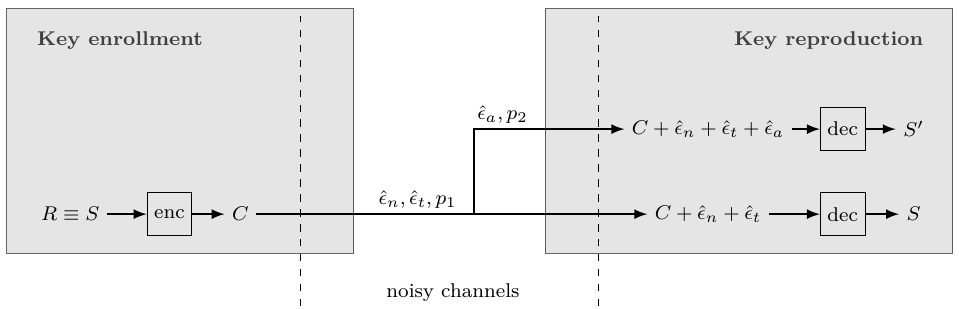
Figure 11: A wiretap channel adaptation for measurement noise ˆ (cid:15) n , environmental changes ˆ (cid:15) t and drilling attacks ˆ (cid:15) a